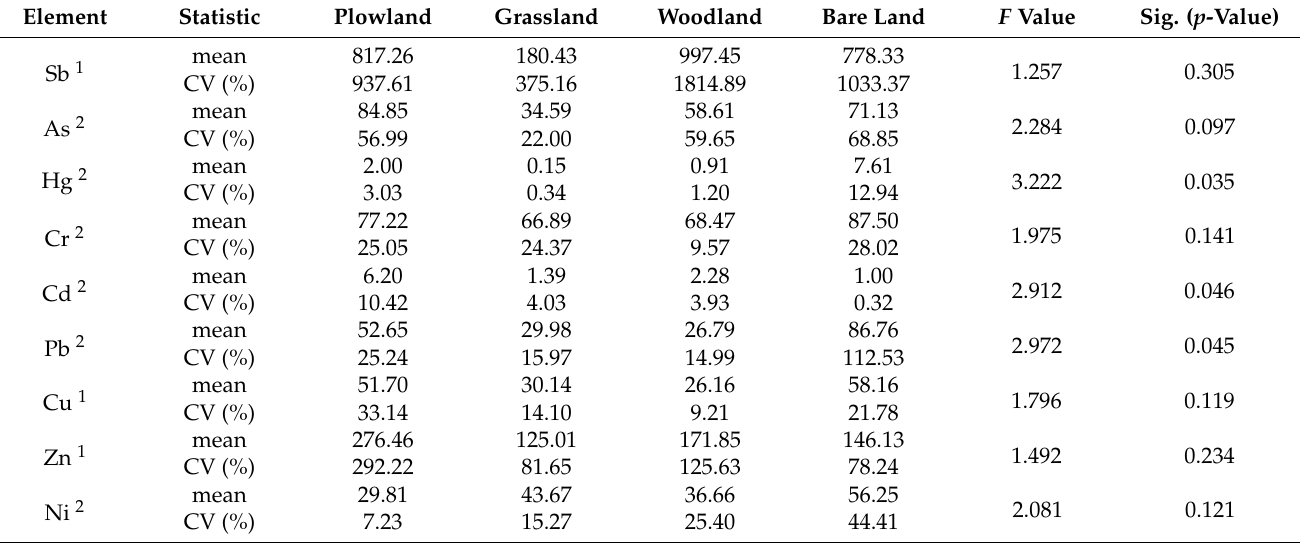
Table 2. Results of ANOVA for soil samples among different land cover